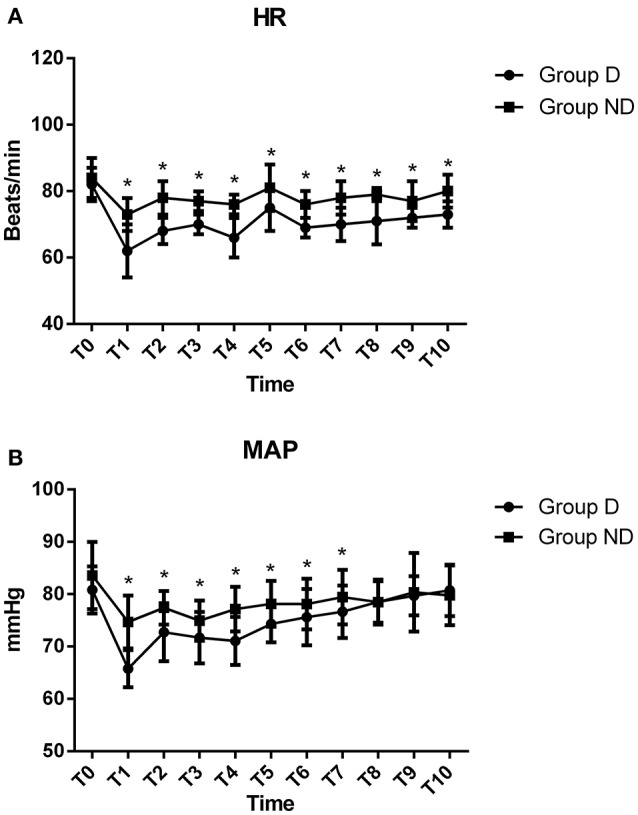
Hemodynamics were monitored in the two groups.